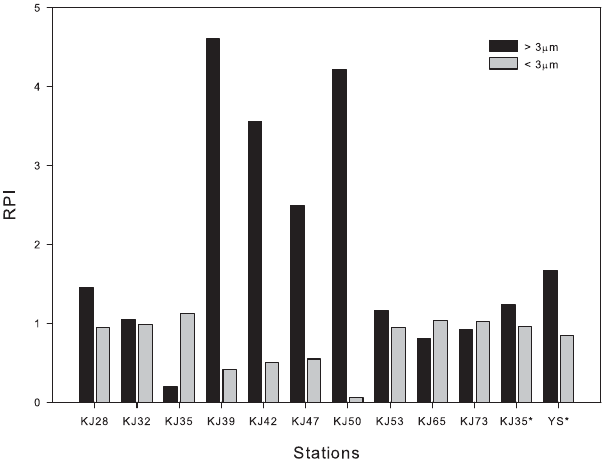
Figure 4. Relative preference index (RPI) for size-fractionated phy- toplankton. > 3µm, size fraction larger than 3µm; < 3µm, size fraction smaller than 3µm; the asterisk indicates experiments con- ducted in May 2009, others were conducted in November 2010. RPI > 1 indicates positive selection and vice